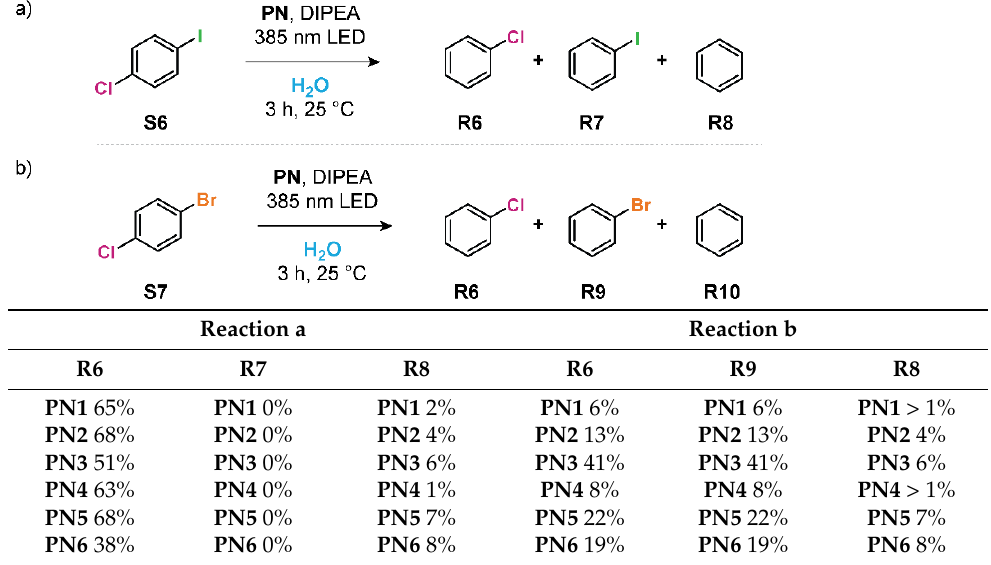
Table 2. Conversions of substituted benzenes S6 – S7 with functionalized polymers PN1 – 6 into